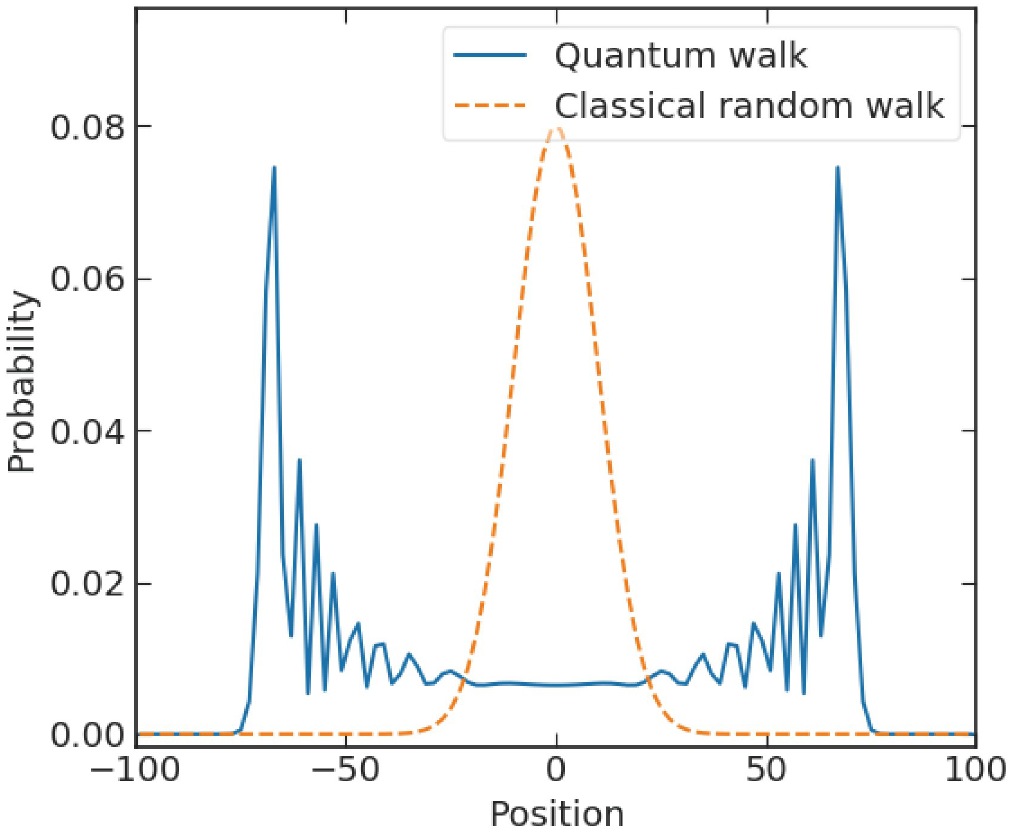
Fig 3. The probability distribution of a discrete-time quantum walk (blue line) and a classical random walk (orange dash line).